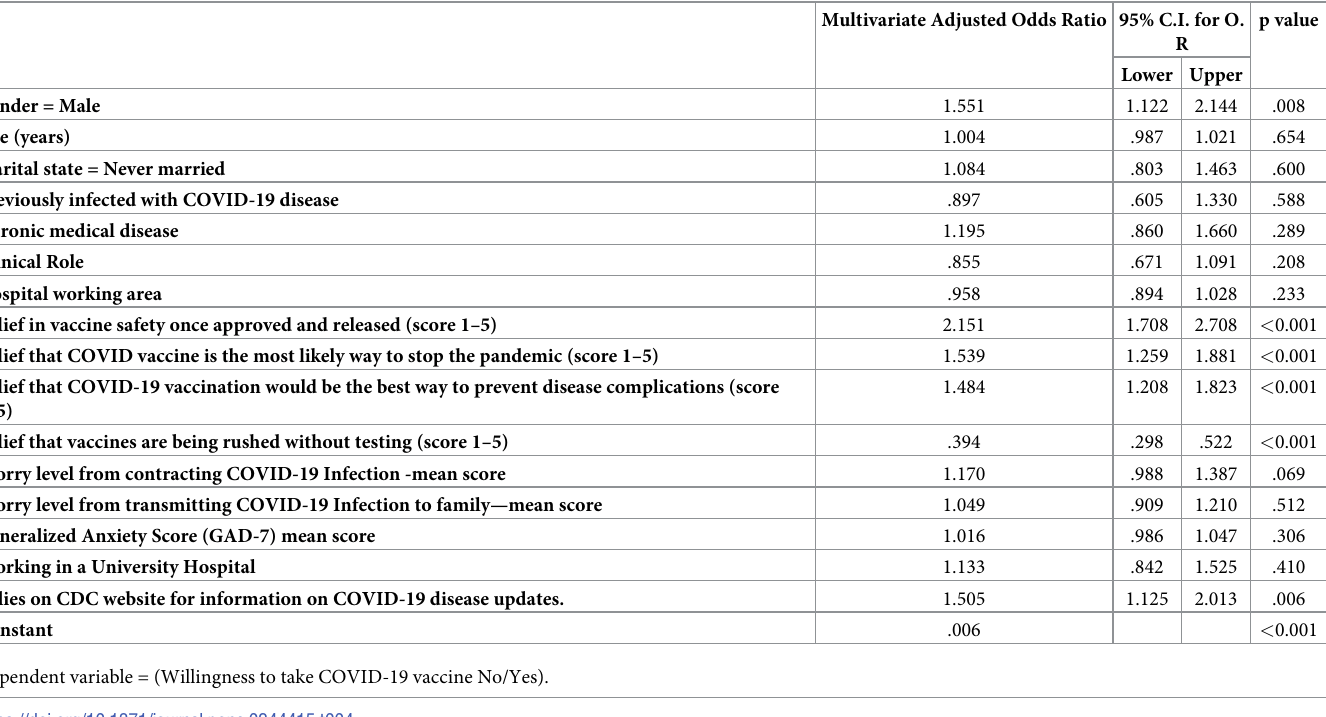
Table 4. Multivariate binary logistic regression analysis of HCWs’ willingness to receive COVID-19 vaccine(s) (N = 1512).